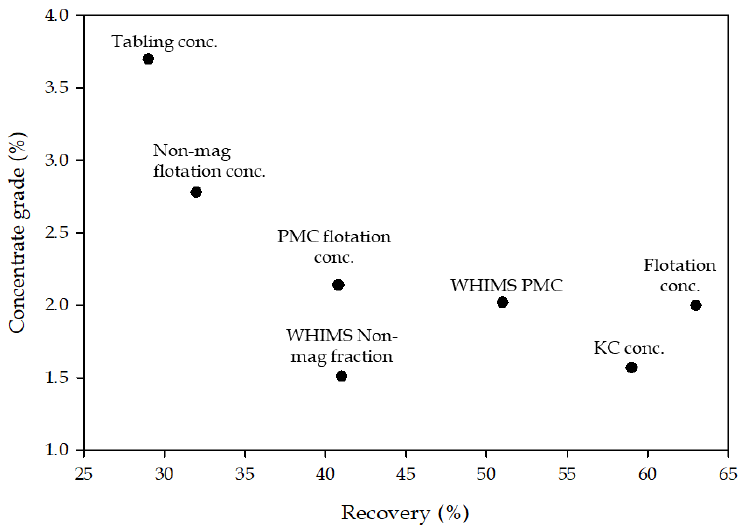
Figure 10. Grade – recovery relation for REE minerals in selected separation products. Table 4. Summary of the mineralogical composition of selected separation